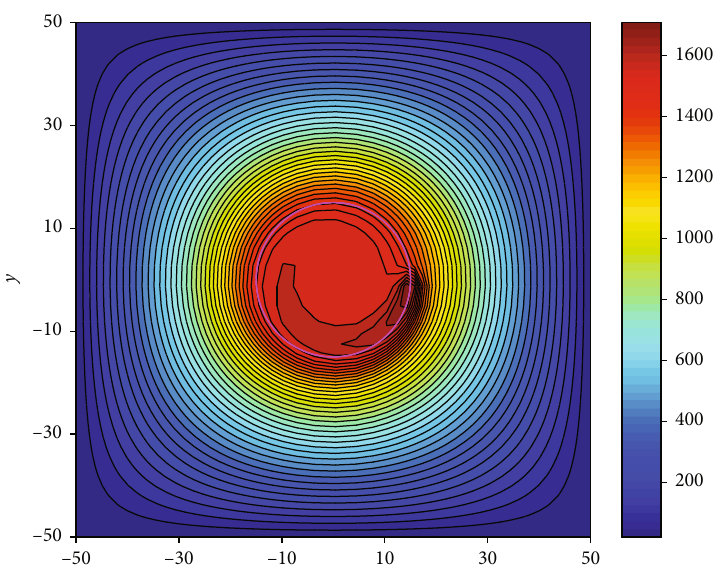
Figure 5: The quasistationary temperature fi eld for a single heat source moving along a circle in a counterclockwise